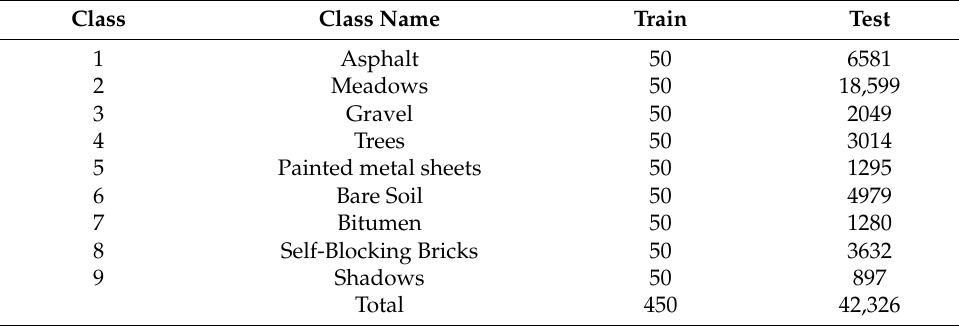
Table 3. Number of training and test sets for the Pavia University data set.